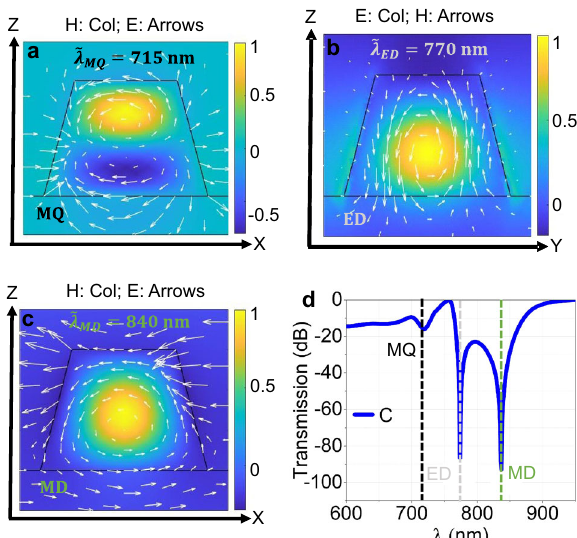
Fig. 2 Quasi-normal modes for metasurface C. a Eigen fi elds (electric fi eld E and magnetic fi eld H distribution) of the eigenwavelength ( ~ λ MQ ) is reminiscent of magnetic quadrupole (MQ) mode, E : shown as arrows and H : shown as colour. b Eigen fi elds (electric fi eld E and magnetic fi eld H distribution) of the eigenwavelength ( ~ λ ED ) is reminiscent of electric dipole (ED) mode, E : shown as arrows and H : shown as colour. c Eigen fi elds (electric fi eld E and magnetic fi eld H distribution) of the eigenwavelength ( ~ λ MD ) is reminiscent of magnetic dipole (MD) mode, E : shown as arrows